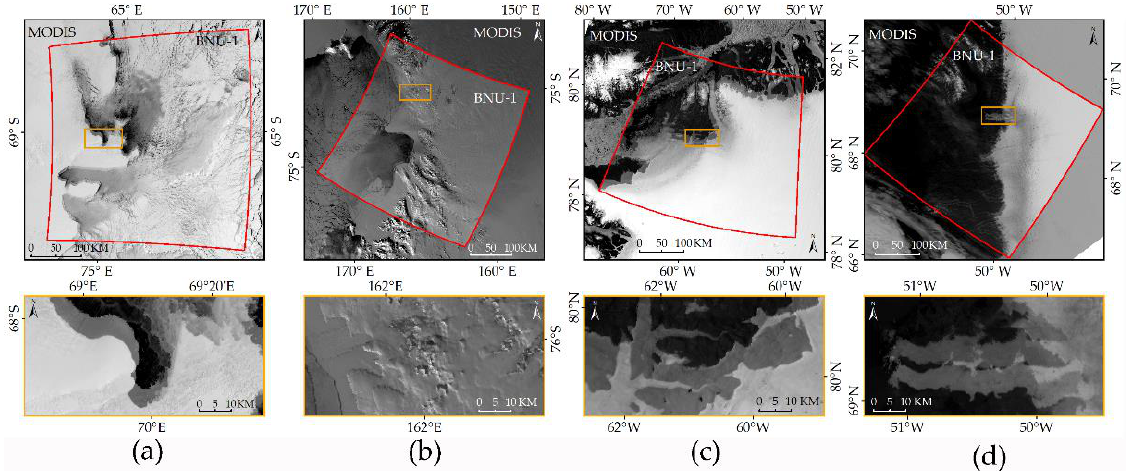
Figure 3. BNU-1 L1A images superimposed on the corresponding MODIS images. Red polygons refer to the outline of the Sample Image scenes shown in Figure 1. ( a ) Sample Image A; ( b ) Sample Image B; ( c ) Sample Image C; ( d ) Sample Image D. The images in the yellow boxes below are the enlarged versions of the part in the sample images. Table 1. Geolocation errors of the BNU-1 L1A/L1B product (unit: meter).